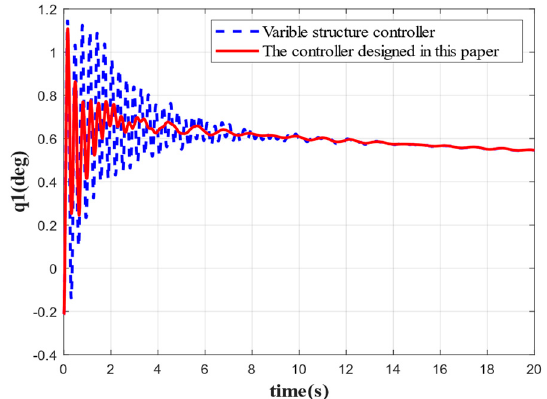
Figure 13. First ‐ order elastic vibration mode with external interference.